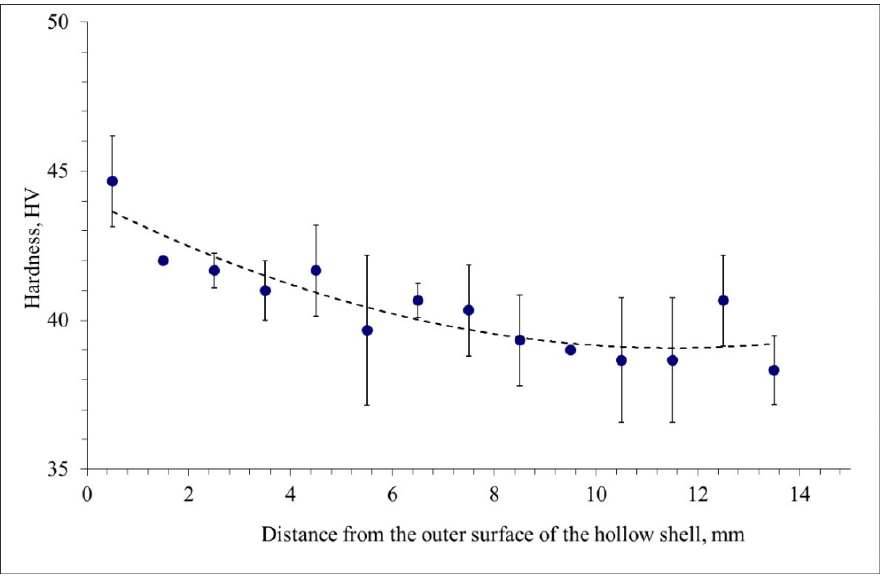
Figure 8. Hardness variation along the wall of the hollow shells pierced by the entire plug ( a ), the plug with a cavity ( b ), and the hollow plug ( c ).